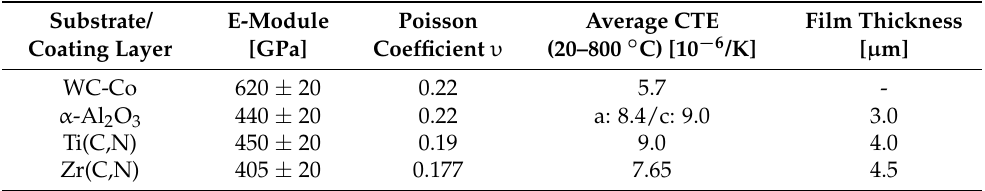
Table 1. Elastic and thermal properties for the substrate and coating materials